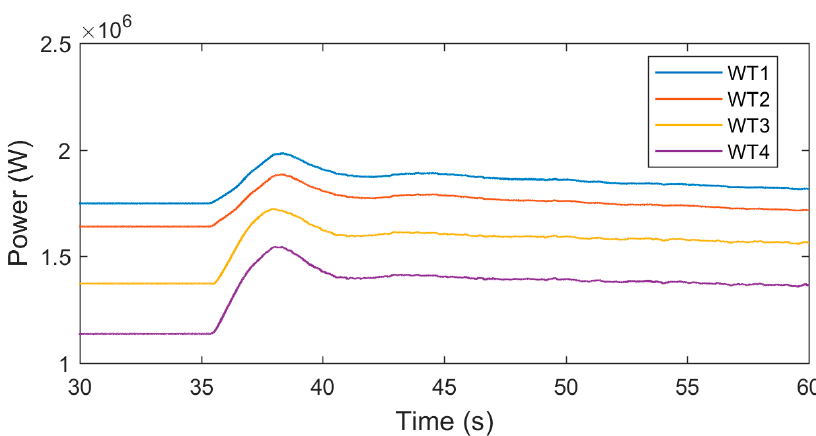
Figure 19. Wind energy systems power (wind farm).